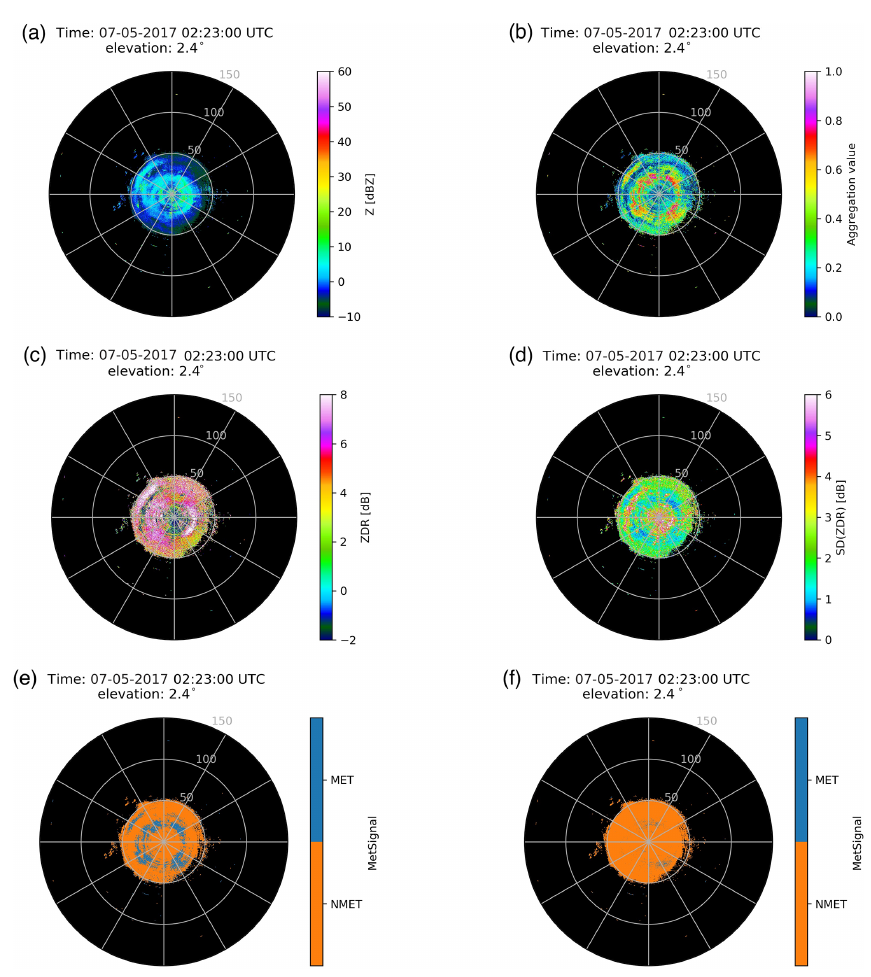
Figure 4. (a) Z , (b) A MET (MetSignal), (c) ZDR, (d) SD(ZDR), (e) MetSignal before post-processing, and (f) MetSignal after post- processing. All from NUIST-CDP at 02:23UTC on 7 May 2017 from an elevation of 2.4 ◦ .